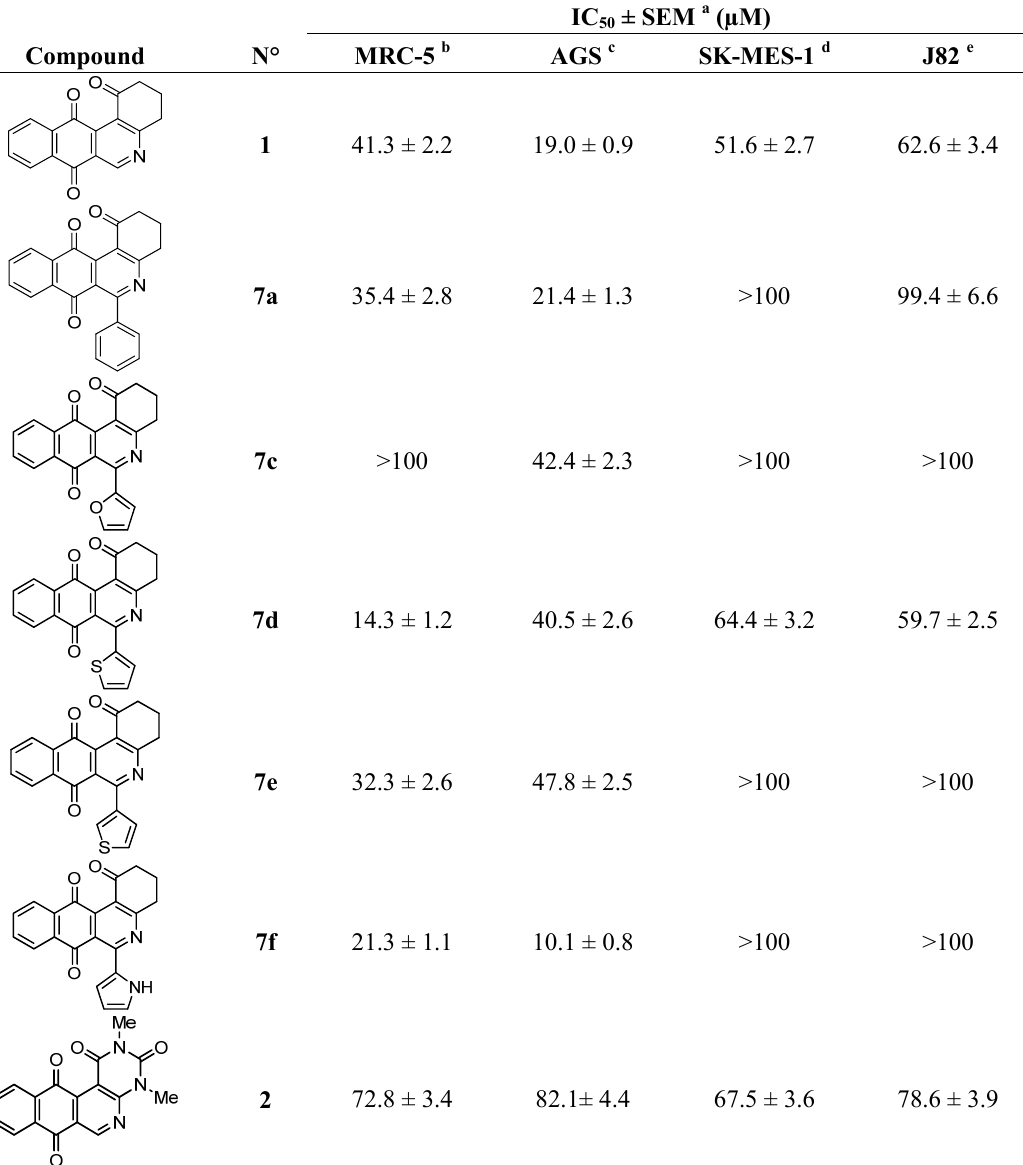
Table 2. Cytotoxic activity of benzo[ j ]phenanthridine- and benzo[ g ]pyrimido[4,5- c ]isoquinolinequinone